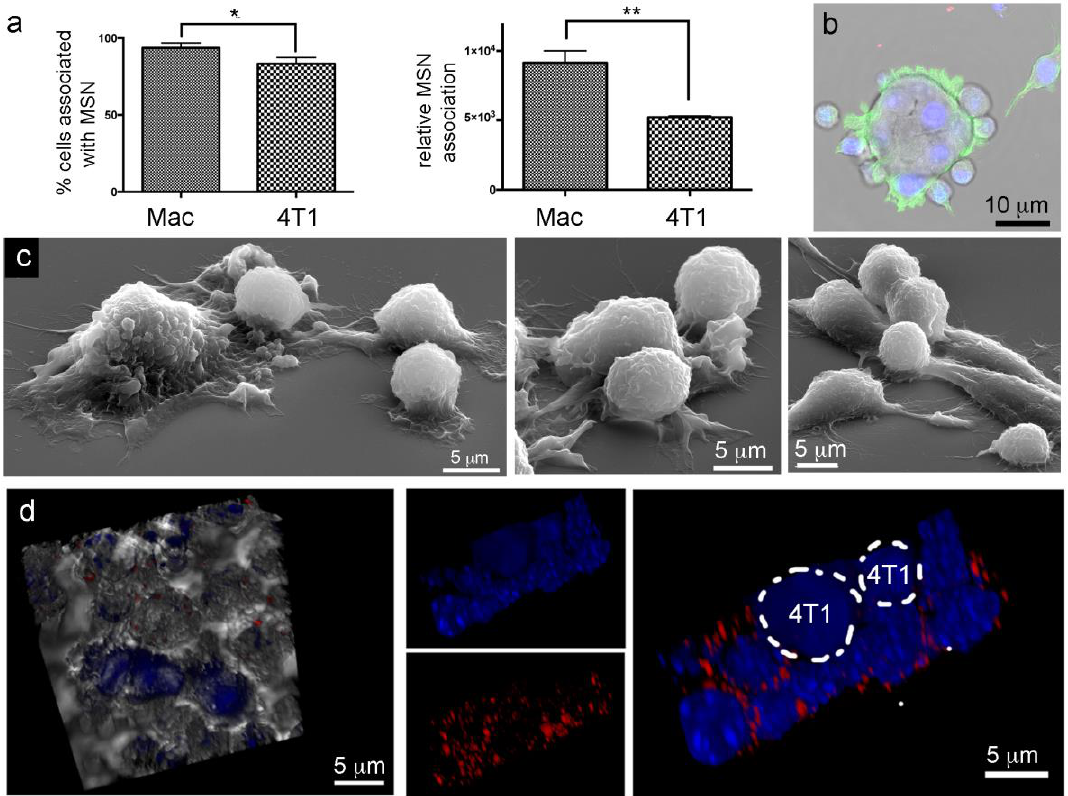
Figure 6. MSN internalization without heterotypic nanoparticle transfer between syngeneic RAW 264.7 macrophages (Mac) and 4T1 cancer cells. ( a ) Flow cytometry analysis of fluorescent MSN uptake presented as percent positive cells and mean uptake per population. ( b ) Merged DIC and fluorescent image of a 4T1 cancer cell surrounded by adherent macrophages (green, phalloidin). ( c ) SEM images of co-cultured 4T1 cancer cells and RAW 264.7 macrophages (round cells) showing direct cellular contact. ( d ) Lack of heterotypic MSN transfer shown using 3D merged DIC and fluorescent images of 24 h co-cultured CellTracker Violet positive 4T1 cancer cells and MSN-loaded (red) macrophages (nuclei, blue, DAPI). * p < 0.05, ** p < 0.01.